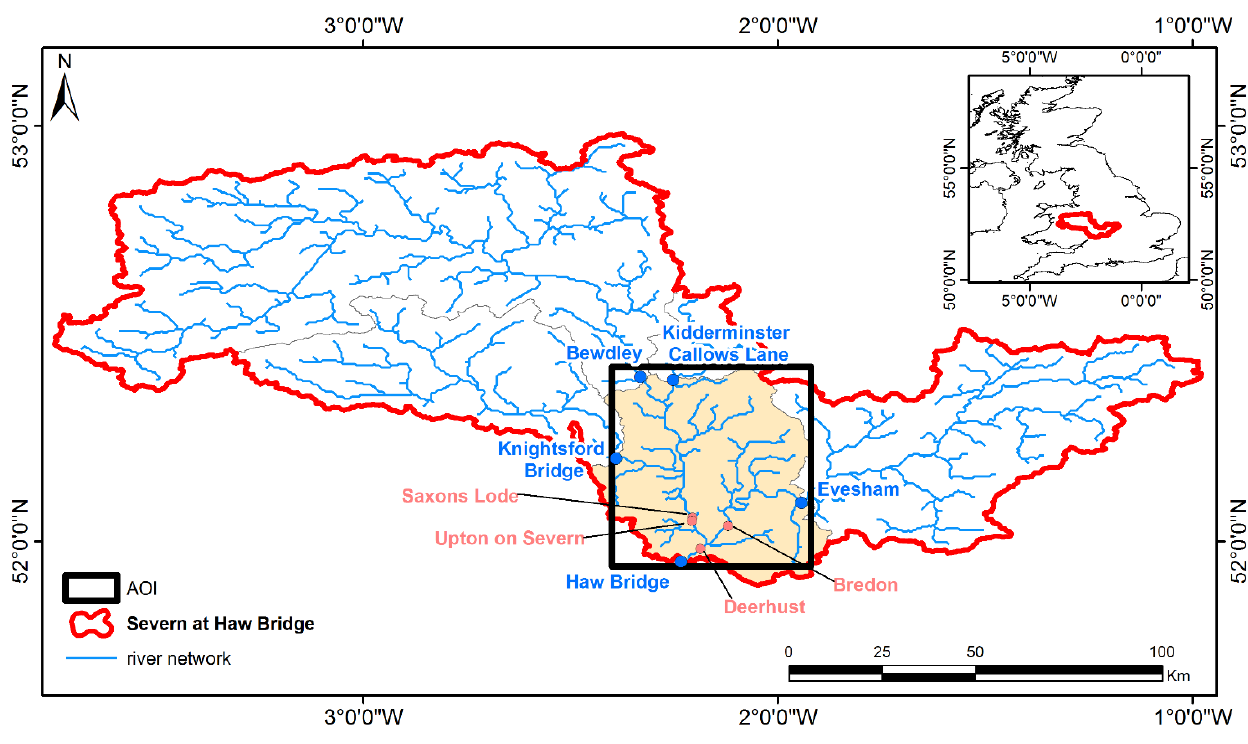
Figure 2. Study site of the River Severn, with its basin (in red) closed at the gauging station of Haw Bridge: the AOI is given by the rectangular box and the dots represent available gauging